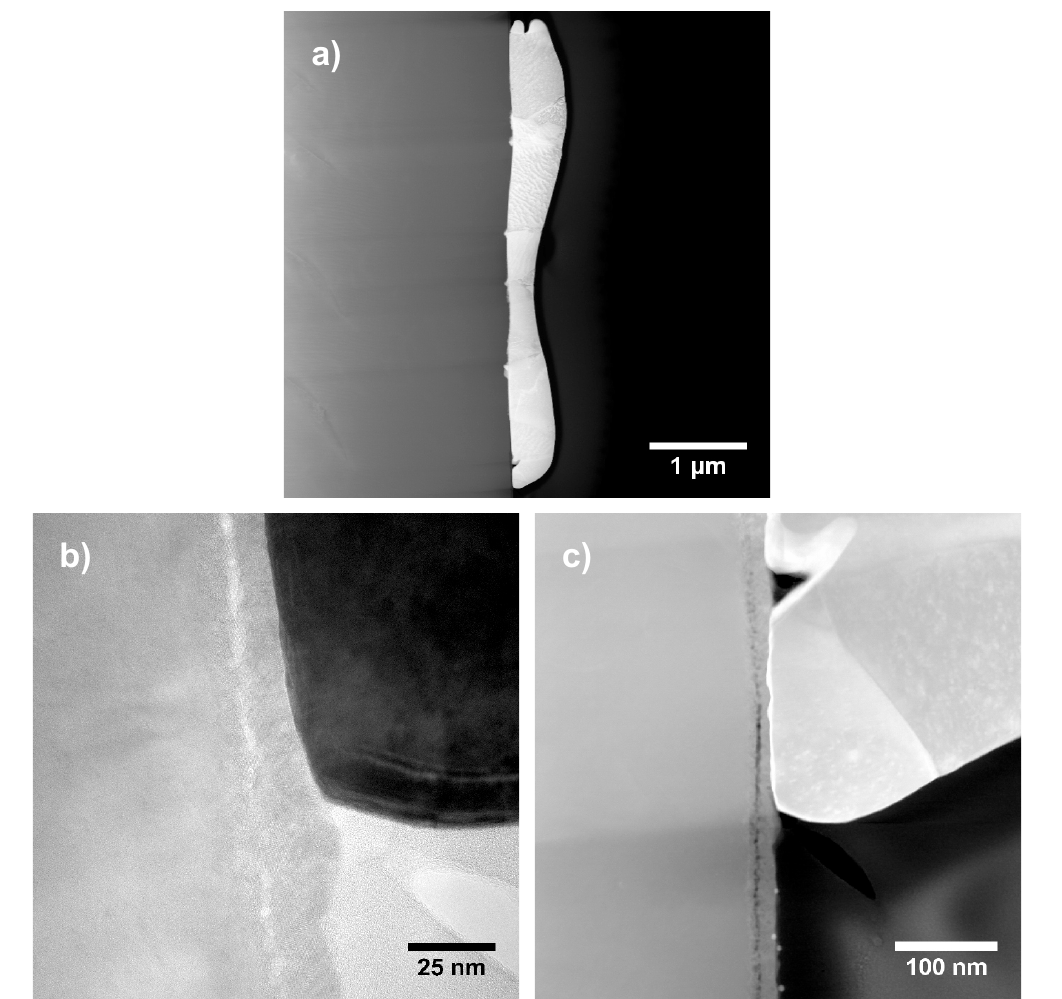
Figure 9. ( a ) STEM HAADF overview of Ti substrate and Pt particle in sample “Au/Pt”; ( b ) TEM BF image of the interface between Ti support and Pt catalyst particle. A 20 nm thick oxide layer is visible. The bright contrast between support and oxide layer indicates less densely packed grains or cavities; ( c ) STEM HAADF image of the edge of a Pt particle. The oxide layer is clearly visible between support and Pt particle. Regions of dark contrast at both interfaces of the oxide layer with the support and the Pt particle indicate regions of less electron scattering. At the bottom part, several 5 to 10 nm small Au nanoparticles can be seen on top of the oxide